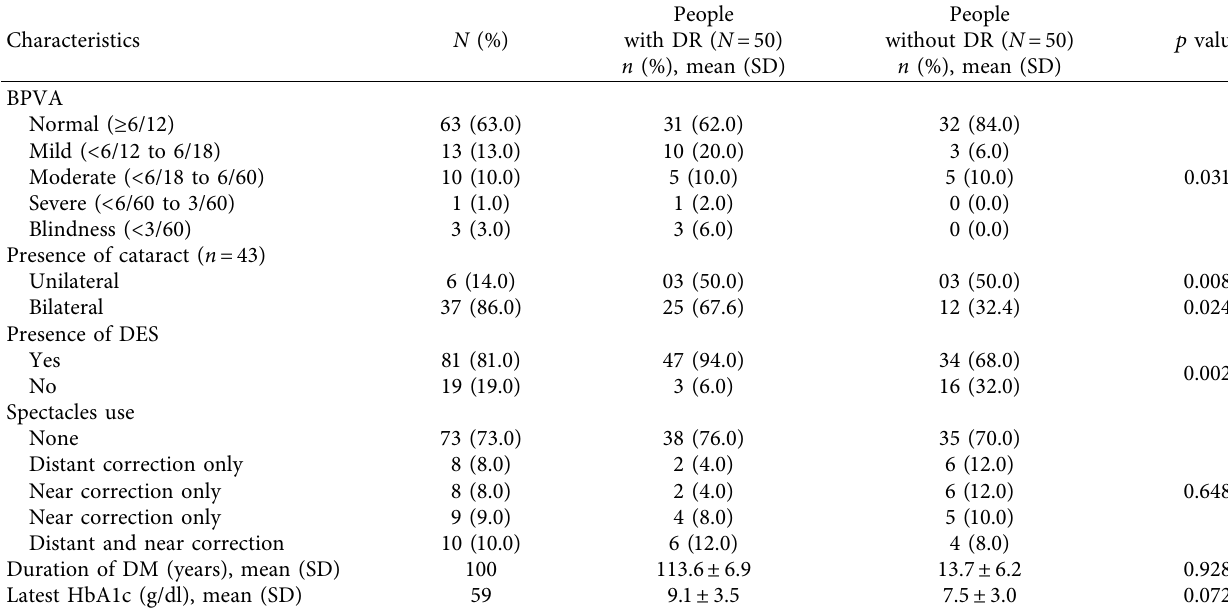
Table 2: Participants’ ocular and medical characteristics in relation to diabetes status at diabetes and eye clinics ( N � 100).